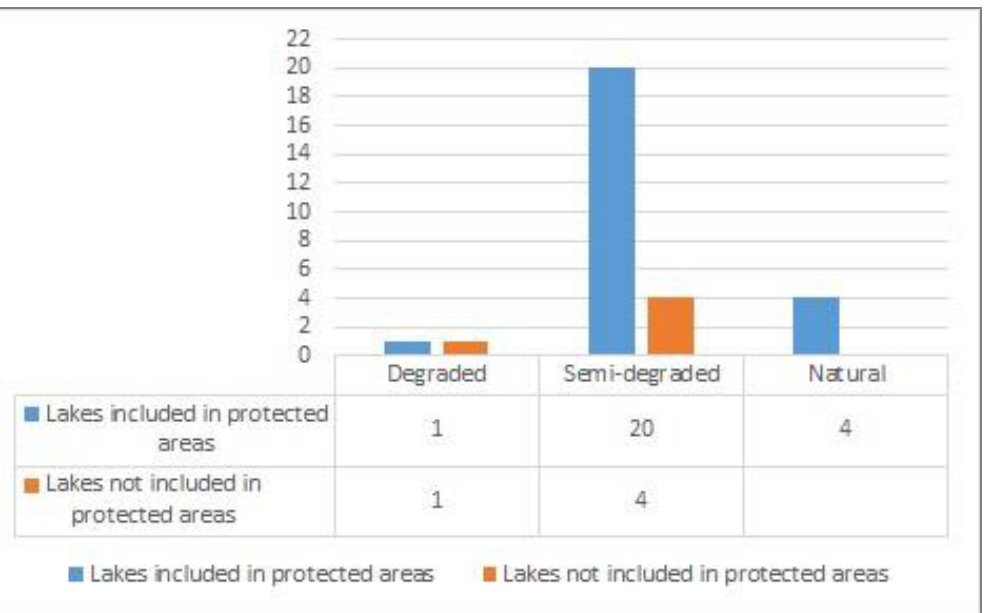
Figure 10. Degradation state in relation to nature protection areas.